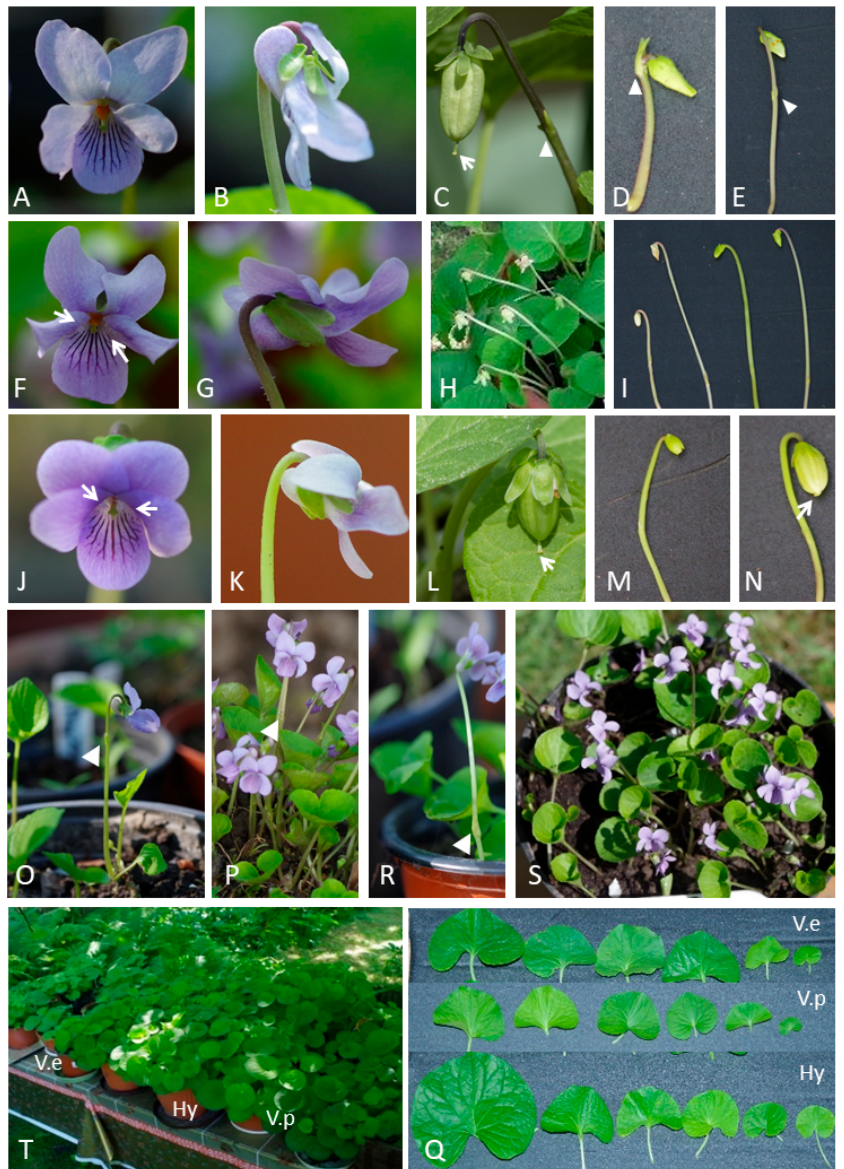
Figure 2. Morphological features of V. epipsila, V. palustris and their putative hybrids. V. epipsila : Face view ( A ) and spur ( B ) of CH flower, capsule of CH flower, visible straight pistil ended with stigma (arrow) and bracts on the pedicel (arrowhead) ( C ), bud-like, fully developed CL flower, visible bracts (arrowhead) ( D ), immature capsule of CL flower, bracts marked with arrowhead ( E ). Putative hybrid: Face view, visible hairs on lateral petals (arrows) ( F ) and spur ( G ) of CH flower, capsules of CH flower arrested in development ( H ), CL flowers arrested in development ( I ). V. palustris : Face view, visible hairs on lateral petals (arrows) ( J ) and spur ( K ) of CH flower, capsule of CH flower, visible pistil ended with stigma (arrow) ( L ), CL flower ( M ), capsule of CL flower, visible curved style (arrow) ( N ). Position of bracts on pedicel (arrowheads) of V. epipsila ( O ), putative hybrid ( P ), V. palustris ( R ). Abundant flowering of putative hybrid in garden conditions ( S ). Plants in the phase after CH flowering, CL flowers at the beginning of development (not visible), note the difficulty in species delimitation at this phase ( T ). Variability in leaf size and morphology ( Q ). CH—chasmogamous flower; CL—cleistogamous flower; V.e— V. epipsila ; V.p— V. palustris ; Hy—interspecific putative hybrid.